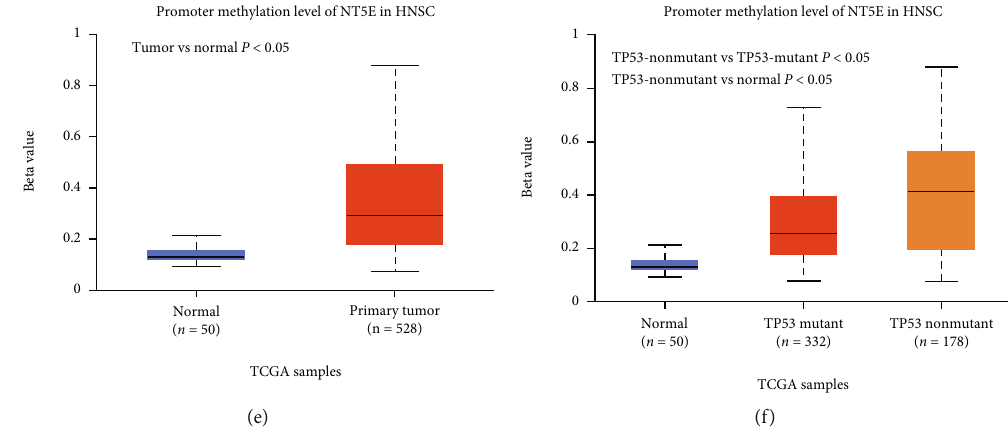
Figure 2: (a) Expression of NT5E in HNSC is signi fi cantly higher than normal tissues (GEPIA): analysis of 519 HNSCCs and 44 normal tissues showed that NT5E was signi fi cantly overexpressed in HNSCC ( P < 0 : 05 ). (b) Expression of NT5E in HNSC based on sample types (UALCAN) showed that NT5E was signi fi cantly overexpressed in HNSCC ( P < 0 : 05 ). (c) Expression of NT5E in HNSC based on HPV status: NT5E expression was more signi fi cant in HPV-negative HNSCC ( P < 0 : 05 ) (d) Expression of NT5E in HNSC based on TP53 mutation status: NT5E expression was more signi fi cant in TP53-mutant HNSCC ( P < 0 : 05 ). (e) Promoter methylation level of NT5E in HNSCC: compared with normal tissues, NT5E had a higher degree of methylation in HNSCC ( P < 0 : 05 ). (f) Promoter methylation level of NT5E in HNSC based on TP53 mutation status: NT5E had a higher degree of methylation in TP53 nonmutant HNSCC ( P < 0 : 05